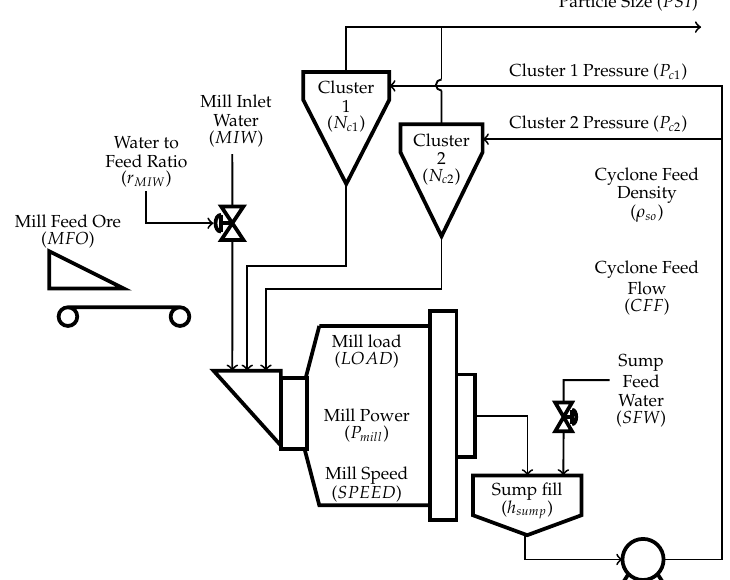
Figure 2. Primary milling circuit with manipulated and controlled variables.